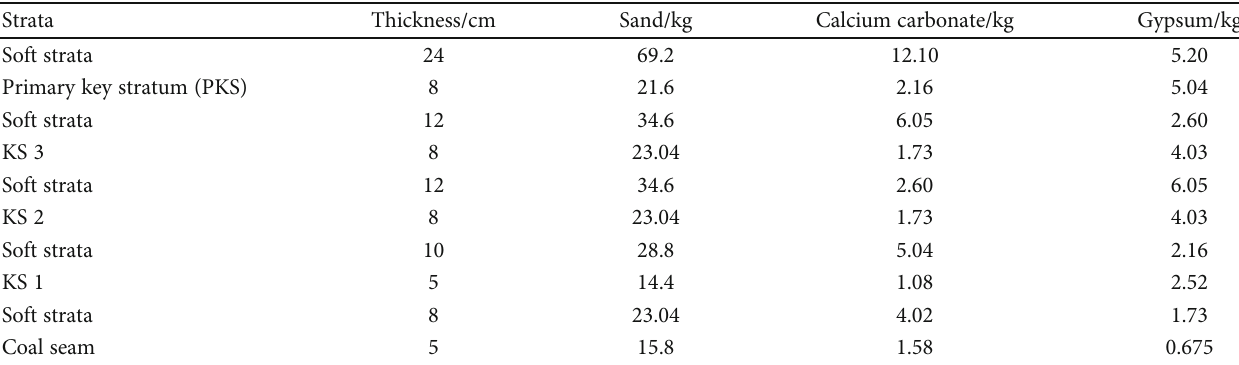
Figure 4: Physical simulation model. Table 1: Similar material proportion for each